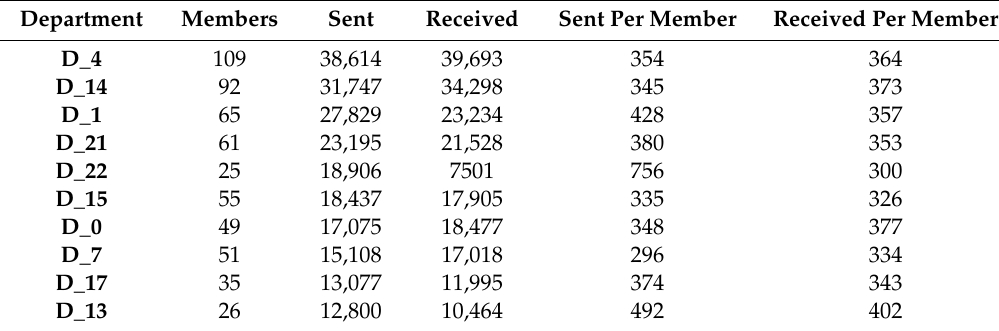
Table 1. Department level statistics (top 10 departments in emails sent).